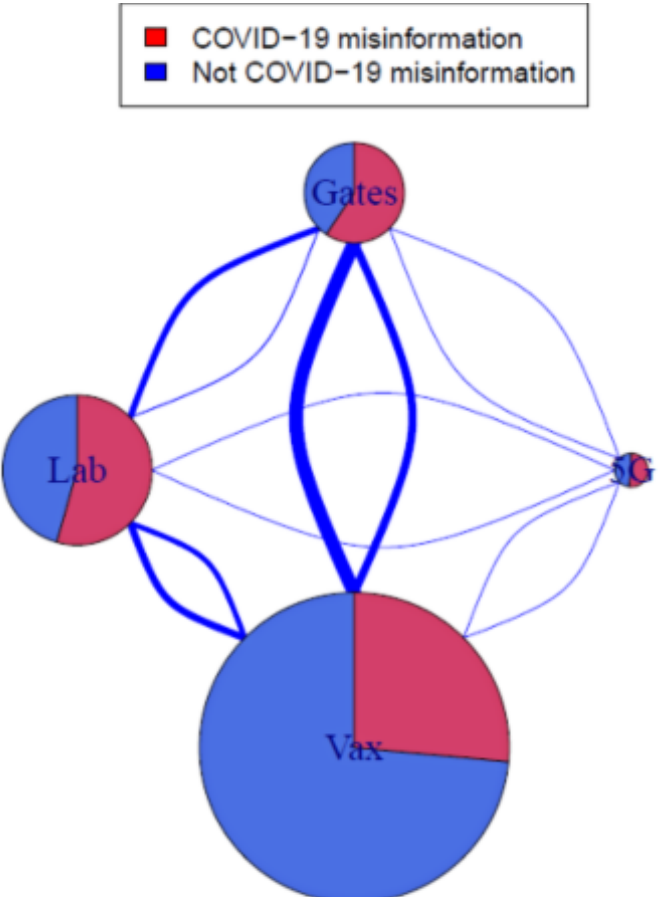
Figure 3. Data set volumes and overlap by theory. The node size indicates the total number of tweets discussing each conspiracy theory, while the edge thickness corresponds to the number of tweets discussing any pair of conspiracy theories simultaneously. 5G: conspiracy theories related to 5G technology; Gates: conspiracy theories related to Bill Gates or the Bill & Melinda Gates Foundation; Lab: conspiracy theories related to SARS-CoV-2 being laboratory-released or human-made; Vax: conspiracy theories related to vaccines.